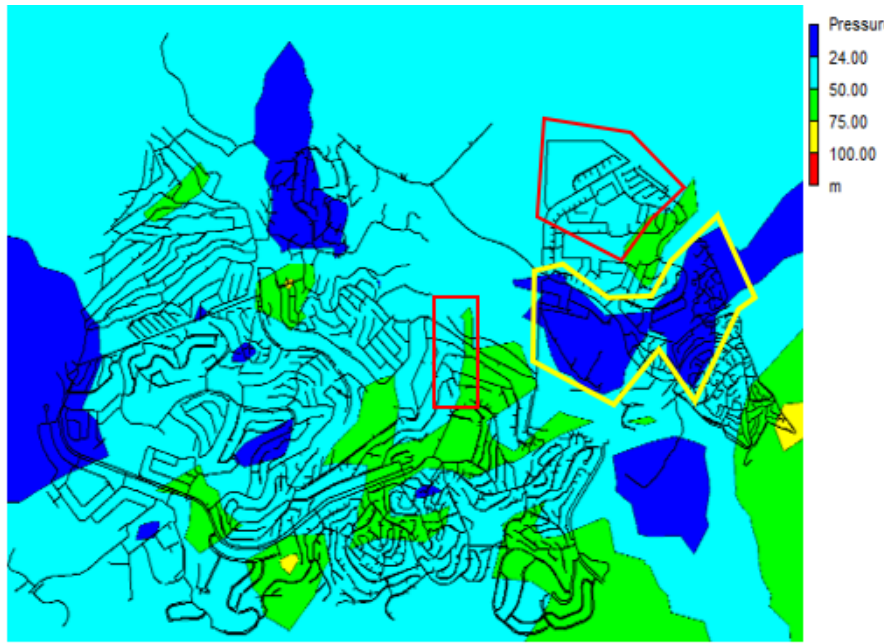
Figure 4. Pressure head in WDN with one PAT installed on pipe no.